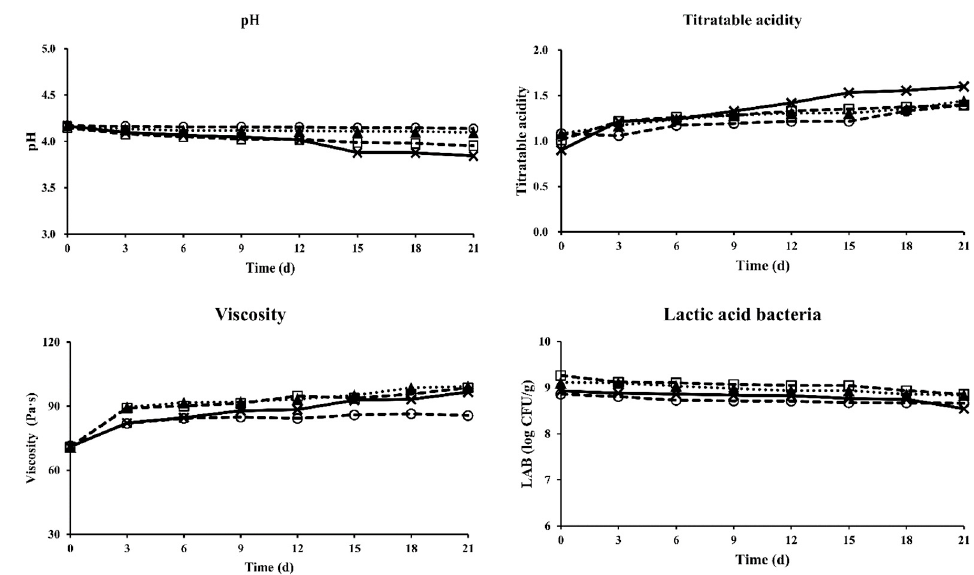
Figure 2. Change of physicochemical characteristics of Greek yogurt with different treatments during storage for 21 days at 4 °C. S. thermophilus and L. bulgaricus (T1): x , S. thermophilus , L. bulgaricus and L. gasseri BNR17 (T2): ○ , S. thermophilus, L. bulgaricus and L. plantarum HY7714 (T3): ▲ , S. thermophilus, L. bulgaricus, L. gasseri BNR17, and L. plantarum HY7714 (T4): □ .